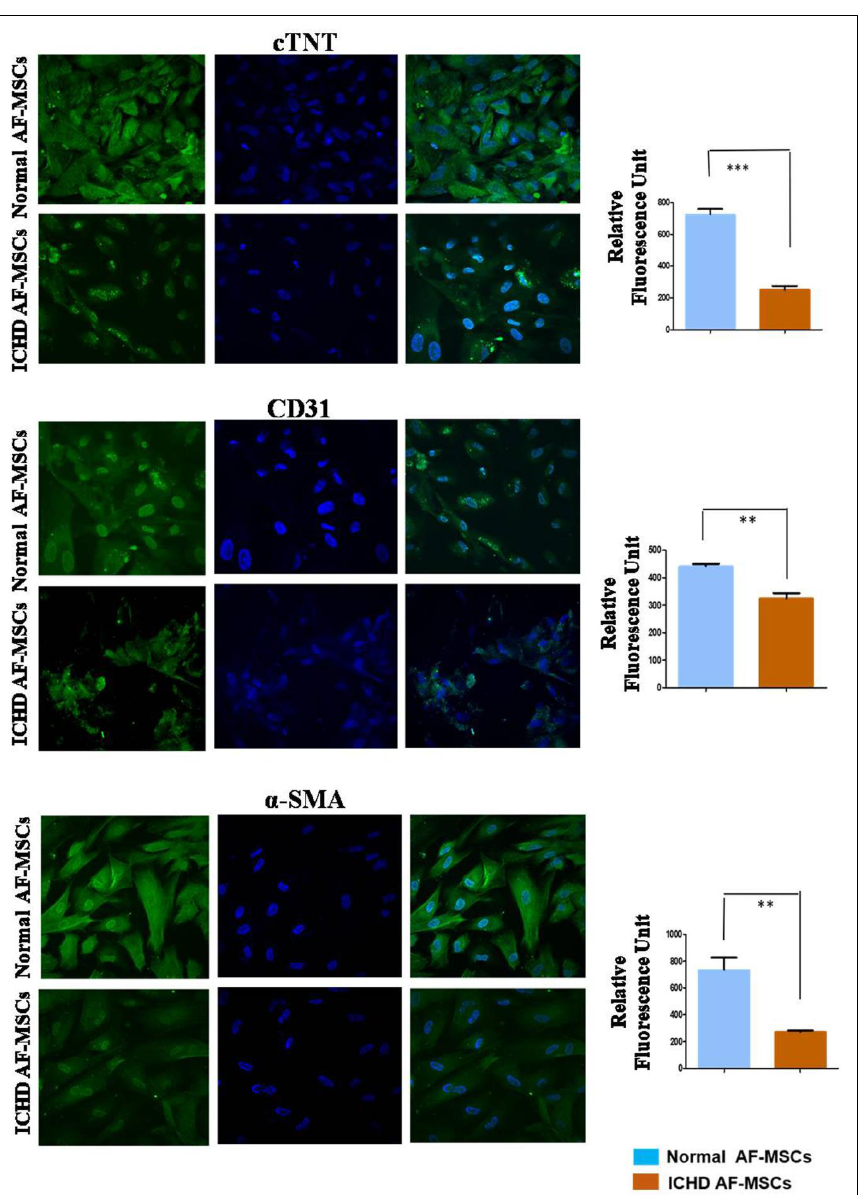
Figure 4. In vitro differentiation of normal and ICHD AF-MSCs into cardiomyocytic-like cells, en- dothelial cells, and alpha-smooth muscle actin. Representative immunofluorescence